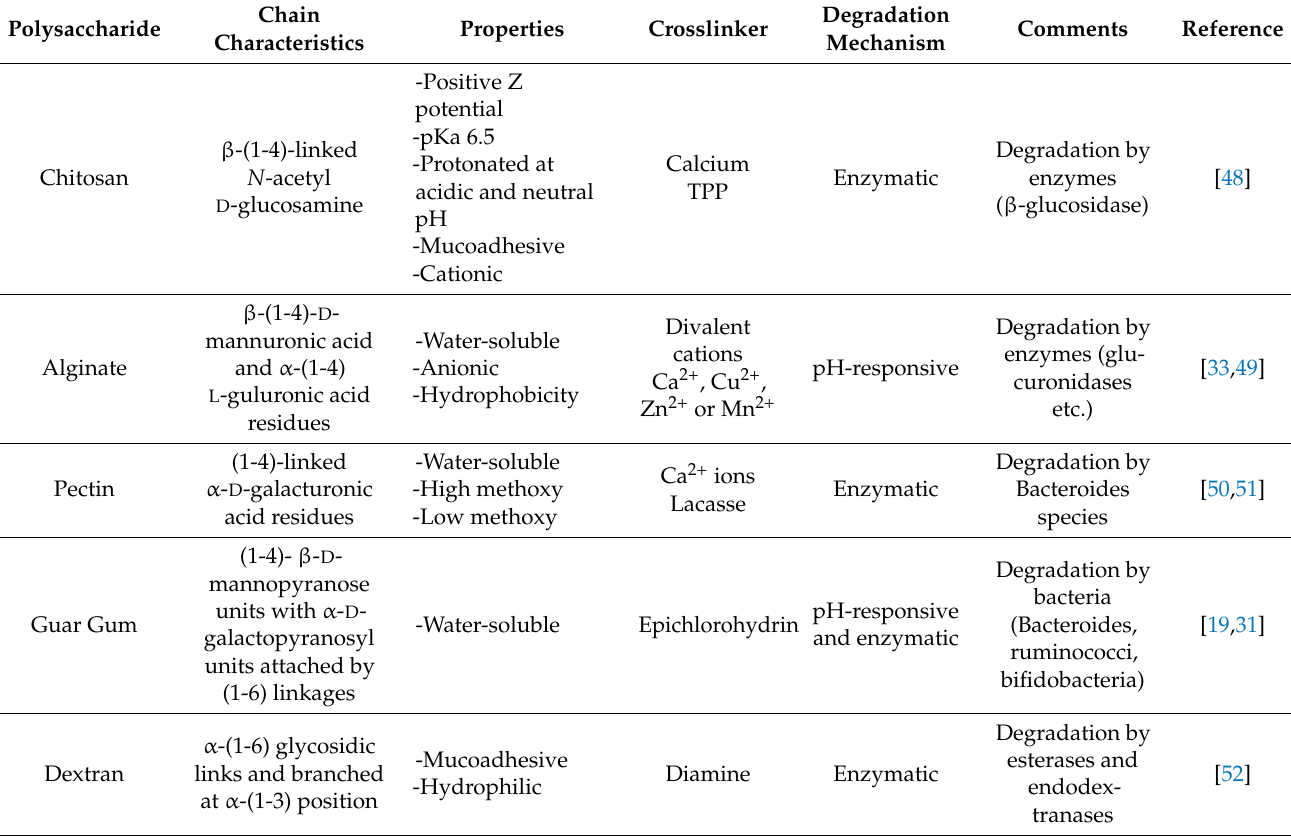
Table 2. Natural polysaccharides, properties, and their degradation